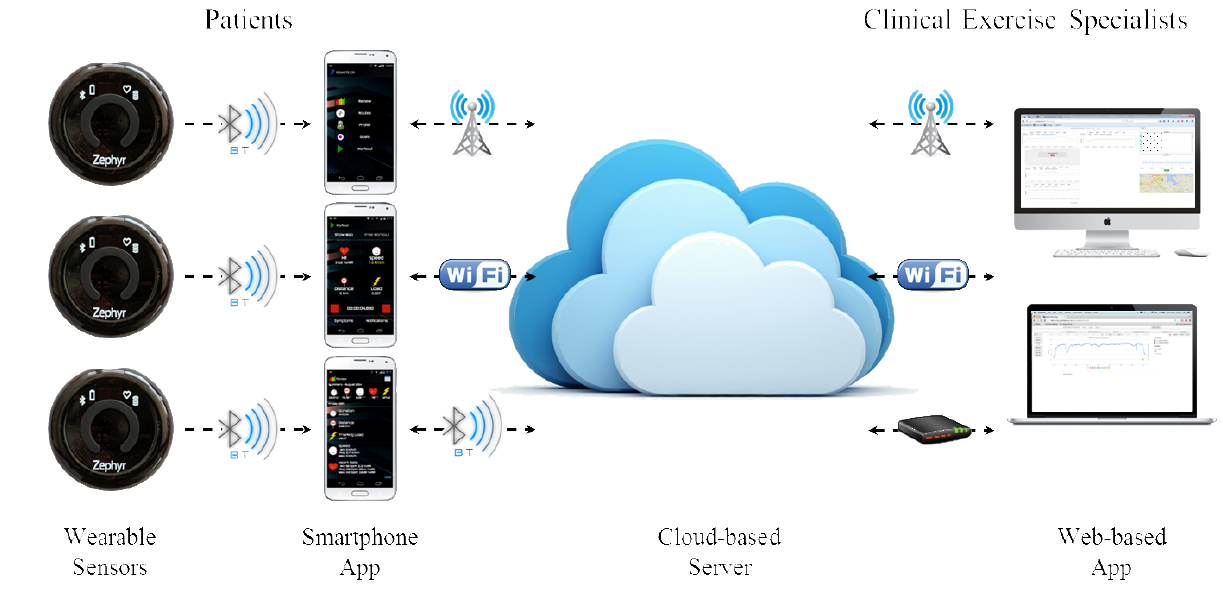
Figure 1. REMOTE-CR platform